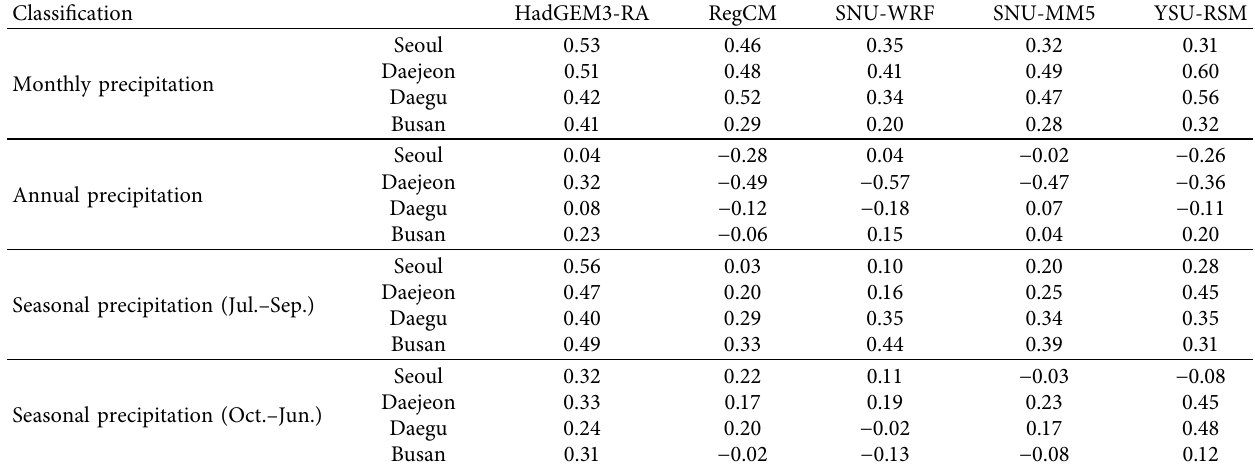
Table 2: Pearson coefficient of precipitation between RCMs and